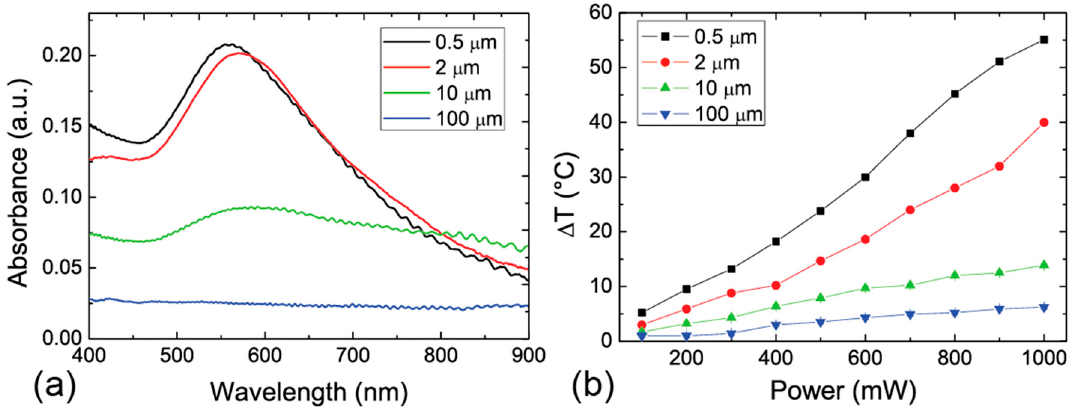
Figure 3. ( a ) Spectral response of the GNP substrate . ( b ) Temperature variations of the GNP different values of the pump beam layer for different values of the pump beam laser.